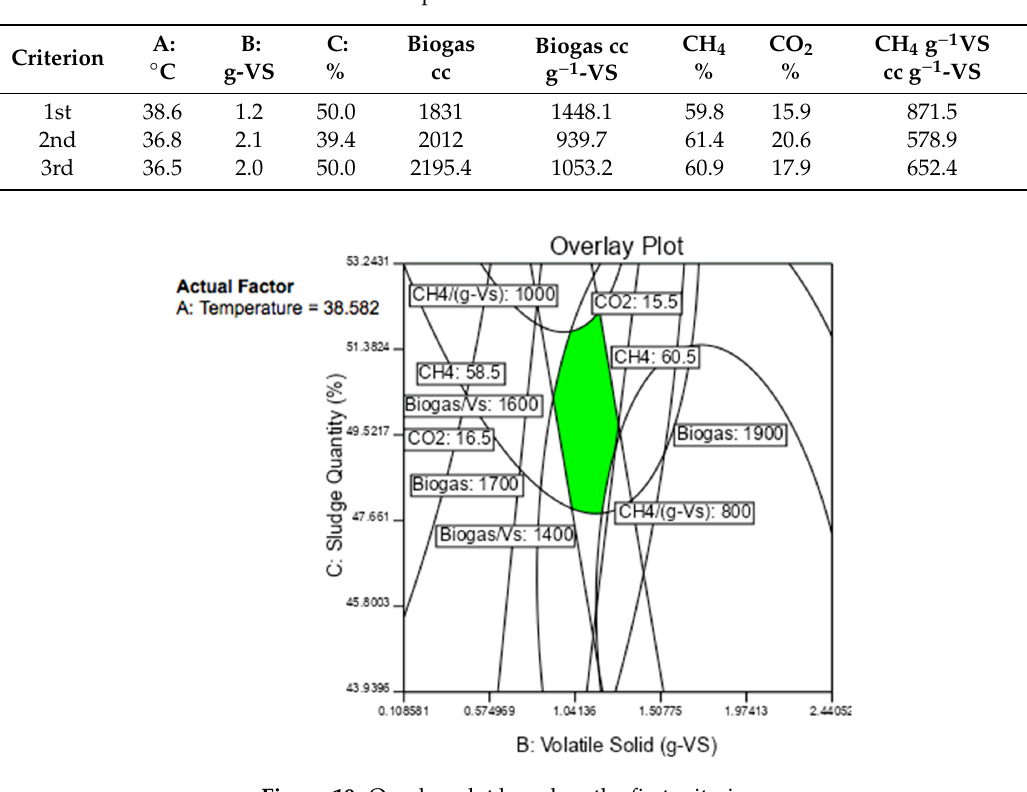
Table 12. The optimal results of the three criteria.